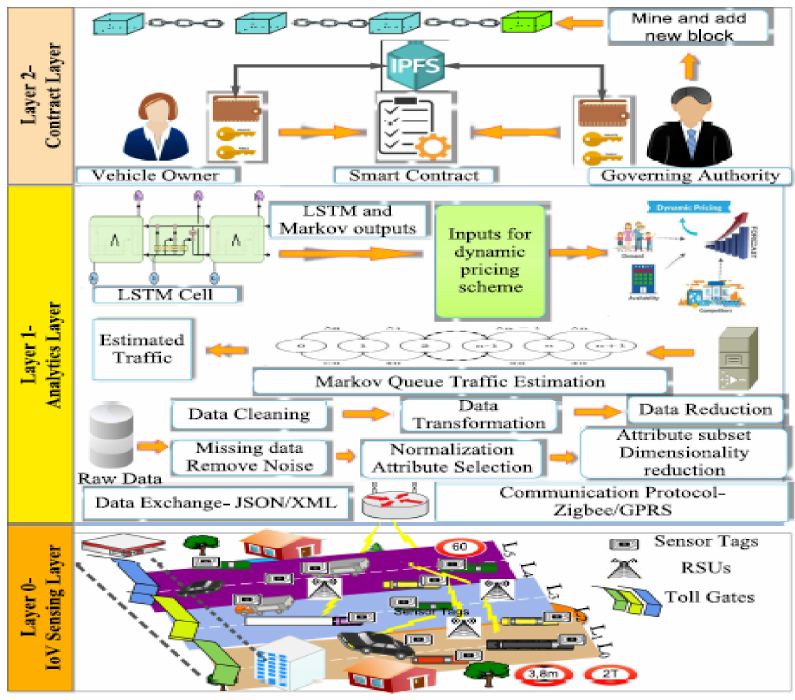
Figure 29. Dwara deep learning framework for dynamic toll pricing [176].